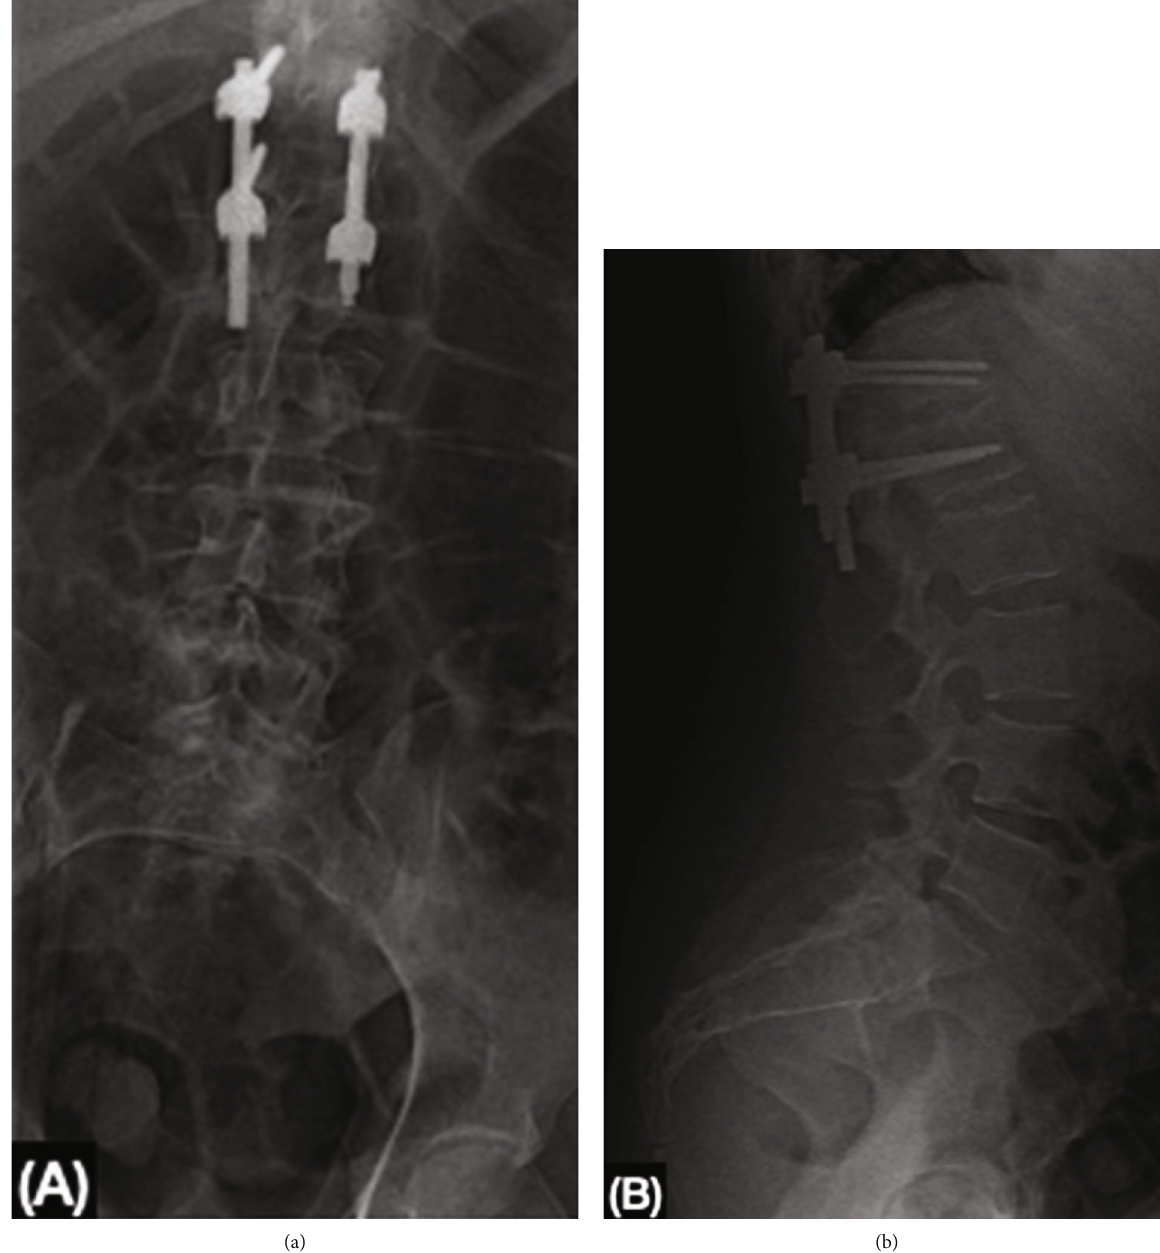
Figure 5: Postoperative x-ray of the lumbar spine: (a) transpedicular screws and rod are seen between T12 and L1. The form and height of vertebral bodies are preserved; (b) appropriate amplitude of inter somatic space. A lumbar angle of 57 ° indicates physiological